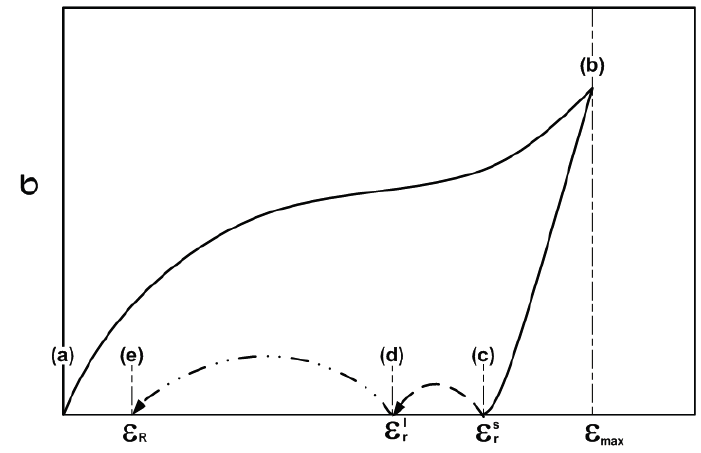
Figure 8. Illustration of the shape memory cycle in terms of stress vs. strain